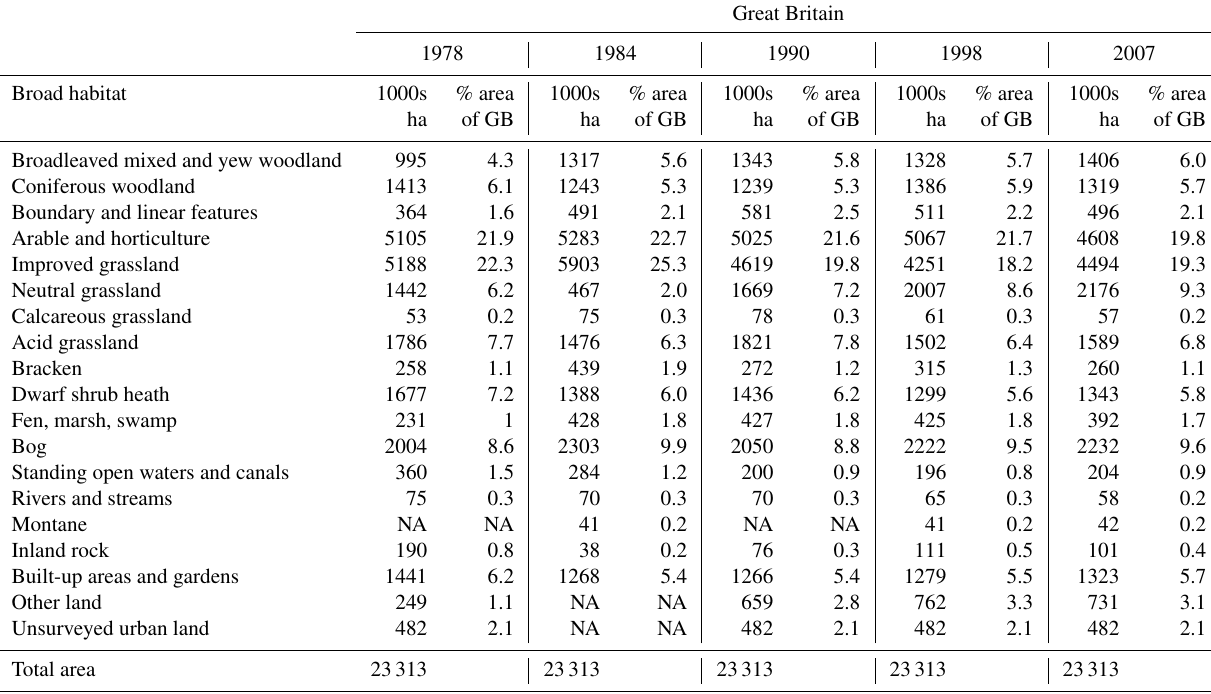
Table 4. Estimated area (thousands of hectares) and percentage of land area of broad habitats in Great Britain from 1978 to 2007. Note that because of changes in definitions that have been applied retrospectively, the estimates from 1990 and more especially 1984 and 1978 are not in all cases directly comparable with later surveys. (Please note that not all the totals are equal to the sum of the column due to unavailable data.)